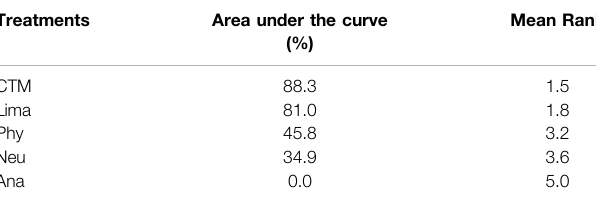
TABLE 5 | Area under the curve and the mean rank for JOA. Treatments